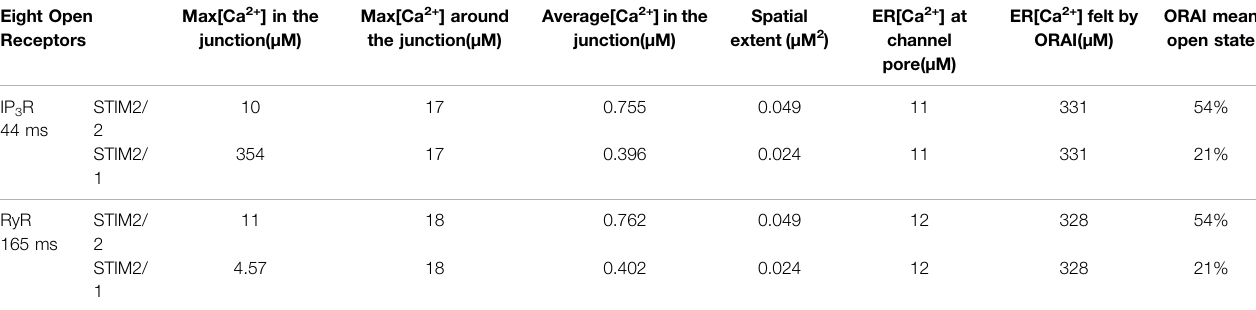
TABLE 1| Characteristicsofthesimulatedmicrodomainsrelying onthesimultaneousopening ofeight IP 3 Rsfor44 ms ( fi rst twolines)orofeight RYR1 for64 ms (linesthree and4).Foreachcase,twosituationsareconsidered:theexistenceofpre-formedclustersofORAI1withSTIM2/2homotetramers(lines1and3)andtheexistenceofpre- formed clusters of ORAI1 with STIM2/1 heterotetramers (lines two and 4). Maximal concentrations denote the maximal local concentrations reached in the domains indicated.Spatialextentreferstotheareaofthejunction ’ sportioninwhichCa 2+ concentrationexceeds300 μ M.TheER[Ca 2+ ]feltbyORAIistheaveragelocalconcentration of luminal Ca 2+ around the mouth of the IP 3 R or RYR1, computed in a 108 nm 3 volume. Eight Open